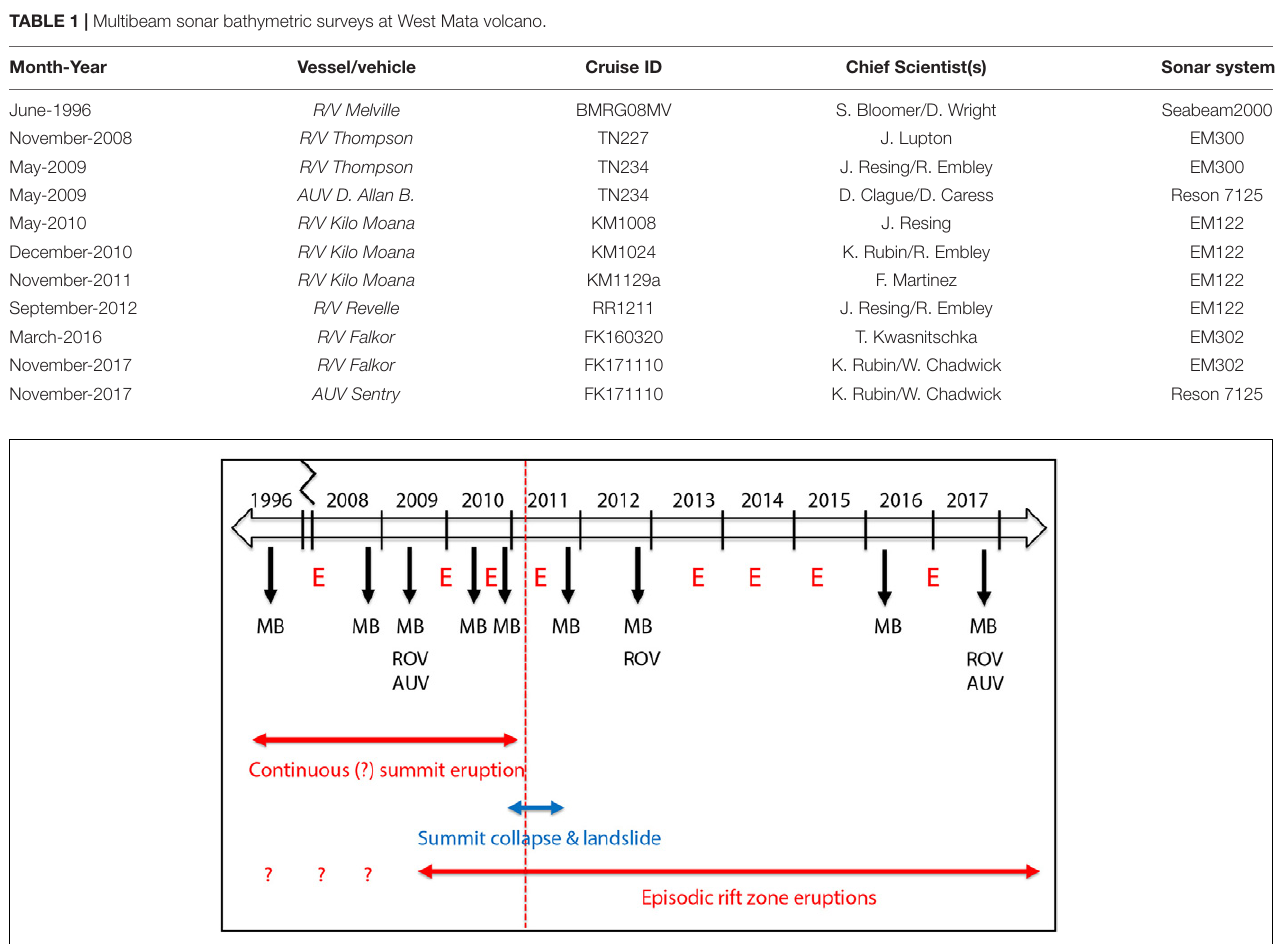
FIGURE 3 | The timeline showing the timing of multibeam sonar bathymetric surveys (MB), AUV and ROV dives in 2009, 2012, and 2017, and the transition in eruptive style from continuous summit activity to episodic rift zone eruptions (represented by red “E’s” below the timeline). TABLE 2 | Estimates of the thicknesses, areas, and volumes of recent eruption sites at West Mata based on depth changes between ship-based bathymetric surveys. Bathymetric